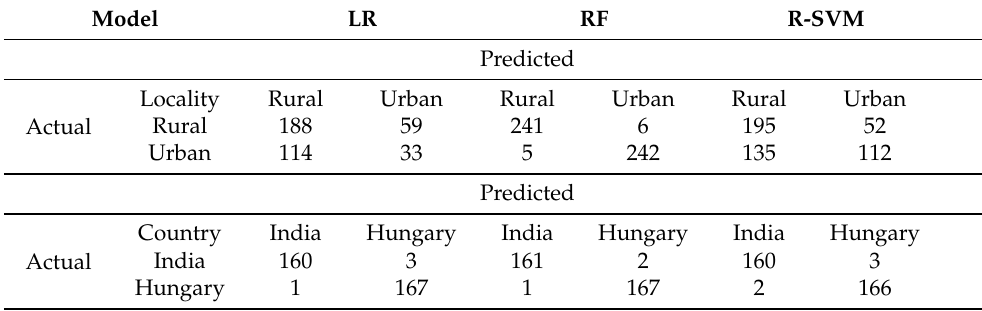
Table 7. Confusion matrices for geographic feature identification.